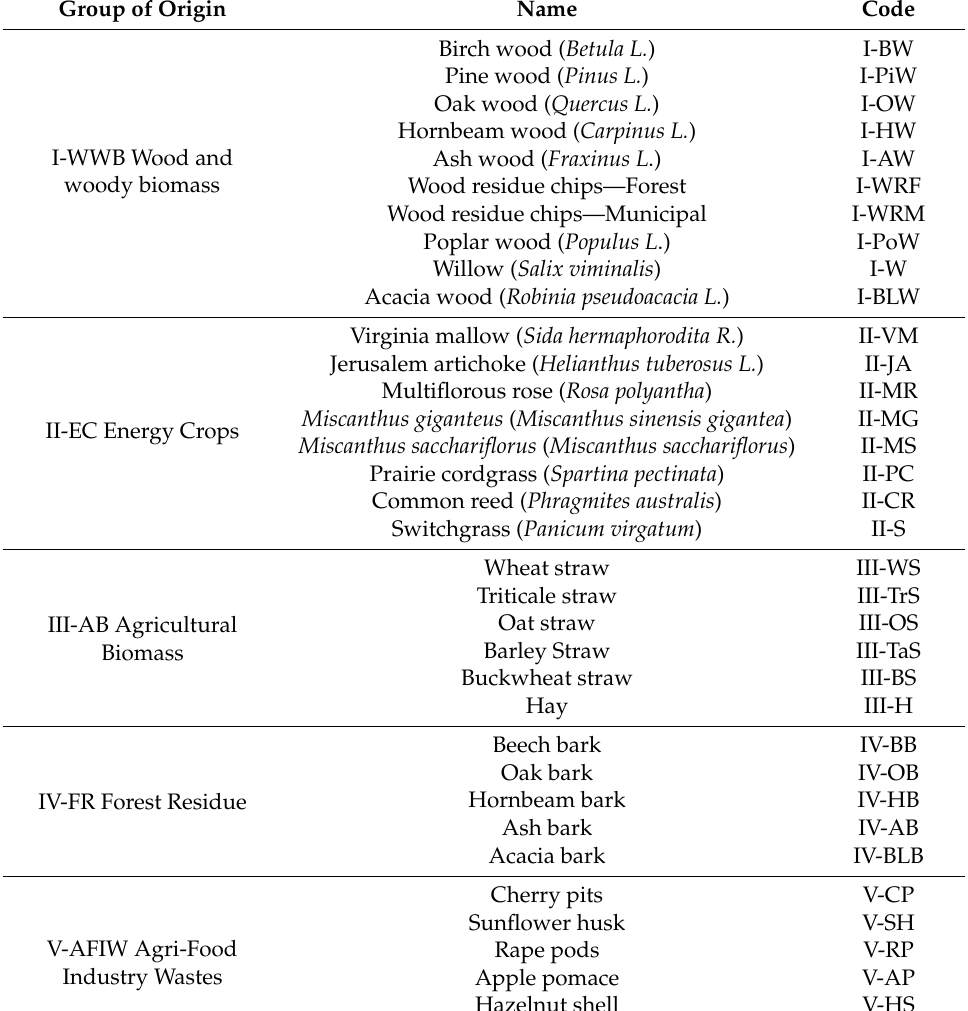
Table 1. Materials and symbols used for the